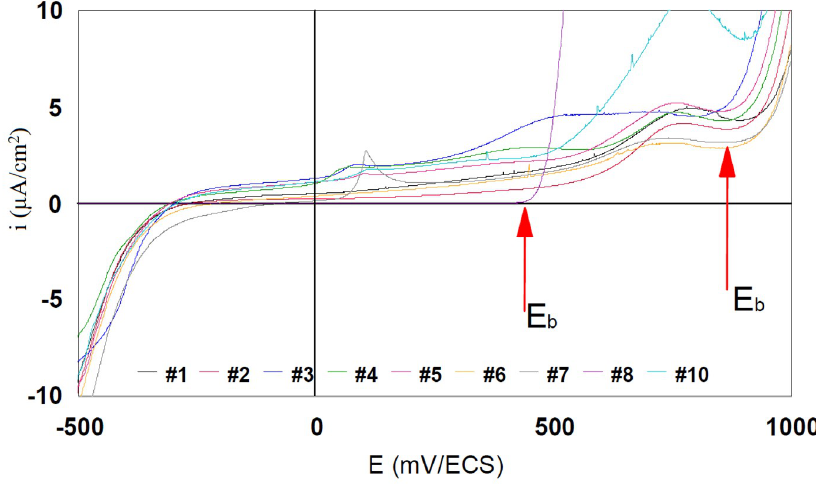
Figure 7. Potentiodynamic curves in linear axes for 317LMN, 904L, and 316L steels.